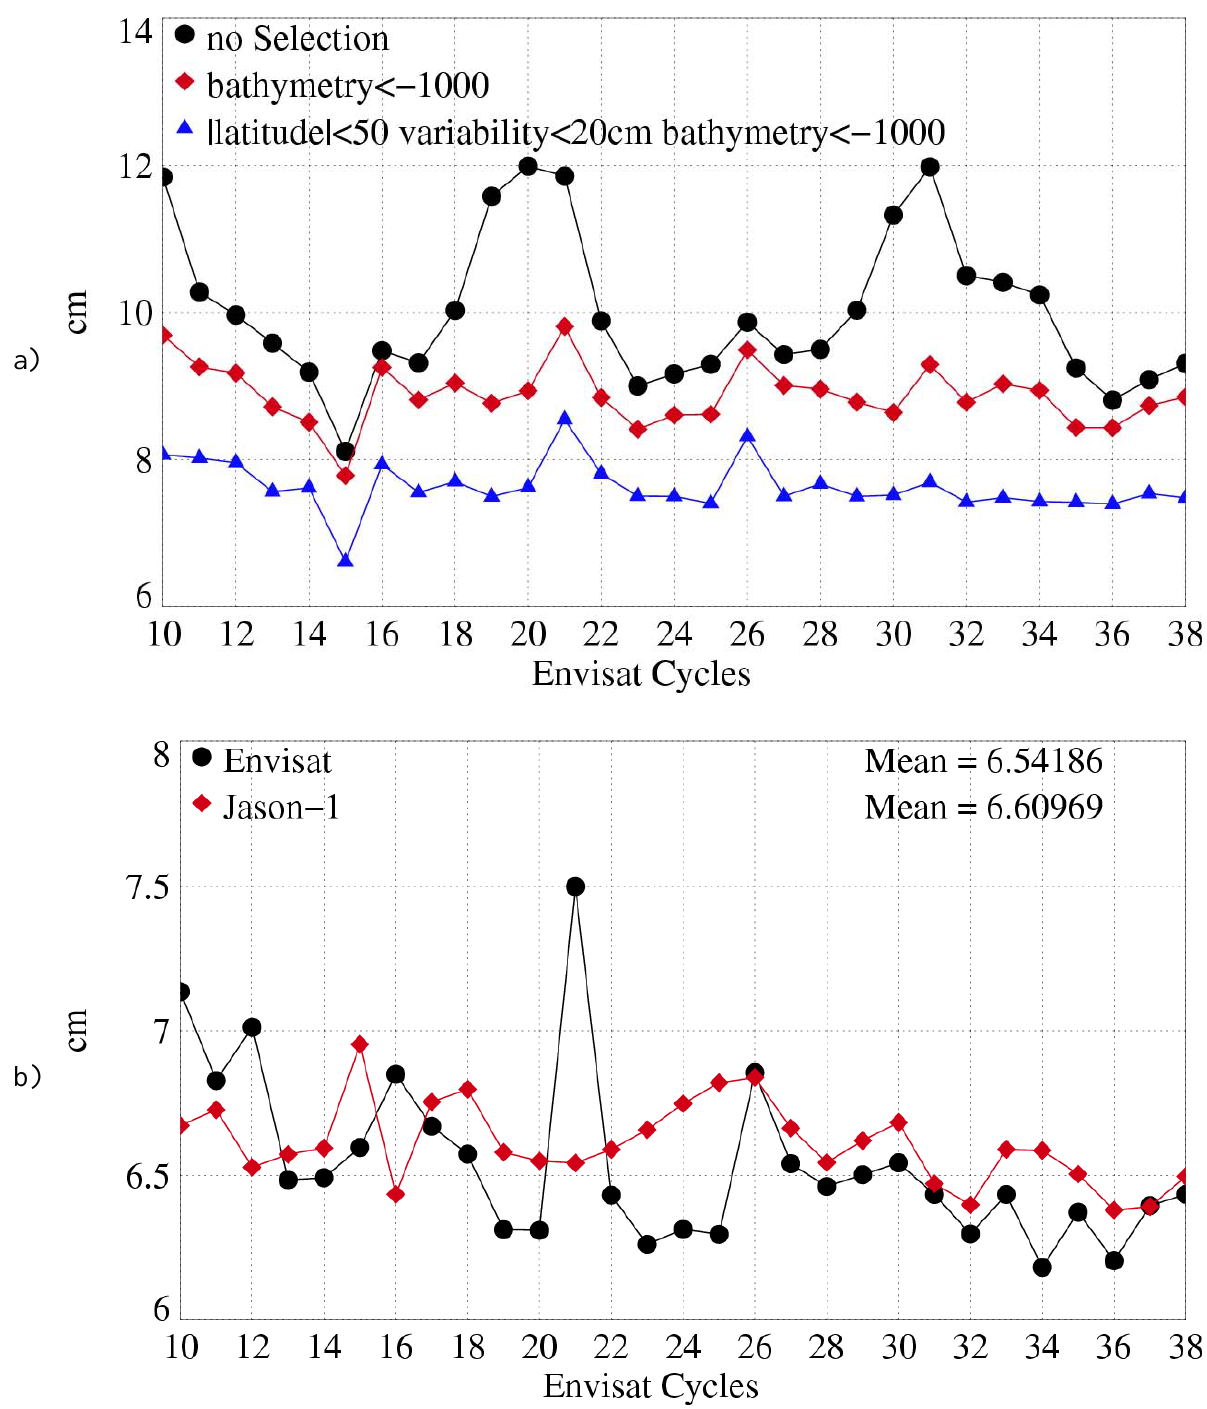
Figure 16. a) Standard deviation (cm) of Envisat 35-day SSH crossover differences depending on data selection. Dots: without any selection. Diamonds: shallow waters (1000 m) are excluded. Triangles: shallow waters excluded, latitude within [-50S, +50N], high ocean variability areas excluded. b) Comparison of the Standard deviation (cm) of Envisat (dot) and Jason-1 (diamond) 10-day SSH crossover